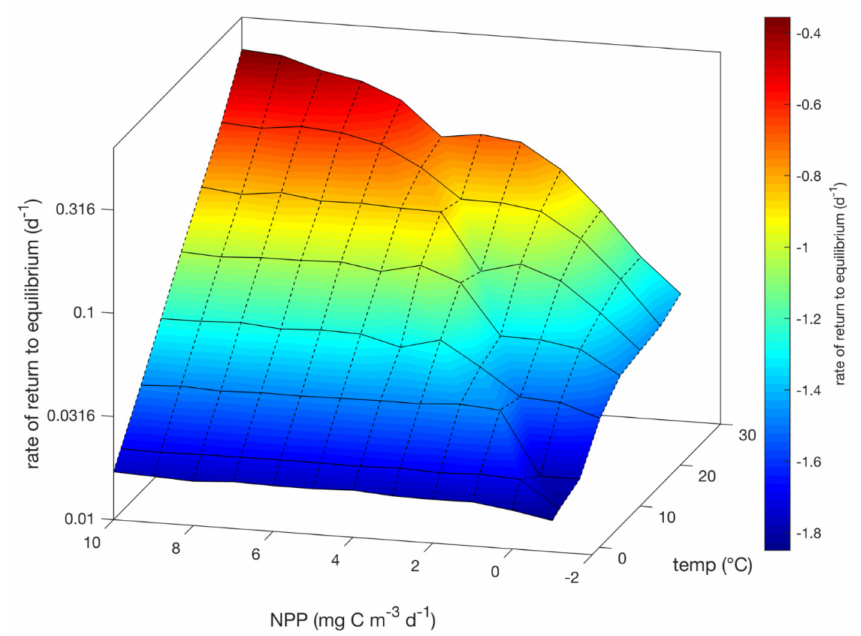
Figure 6. Rate of return to equilibrium after a small perturbation (the magnitude of the real part of the least negative eigenvalue of the community matrix) of the food web model from equilibrium as a function of temperature and